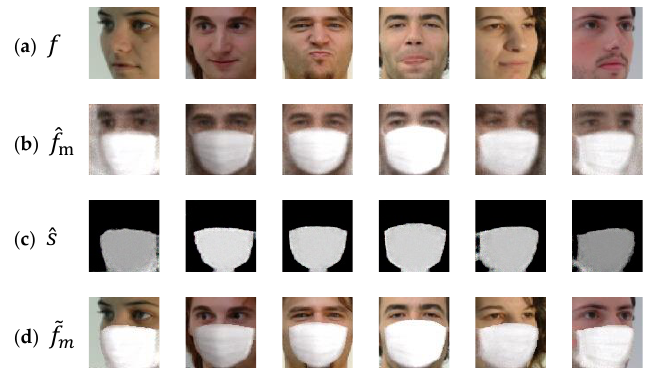
Figure 2. ( a ) Input of the generator 𝐺 p . ( b ) Output of the generator 𝐺 p . ( c ) Output of the generator 𝐺 r . ( d ) The synthesized face.